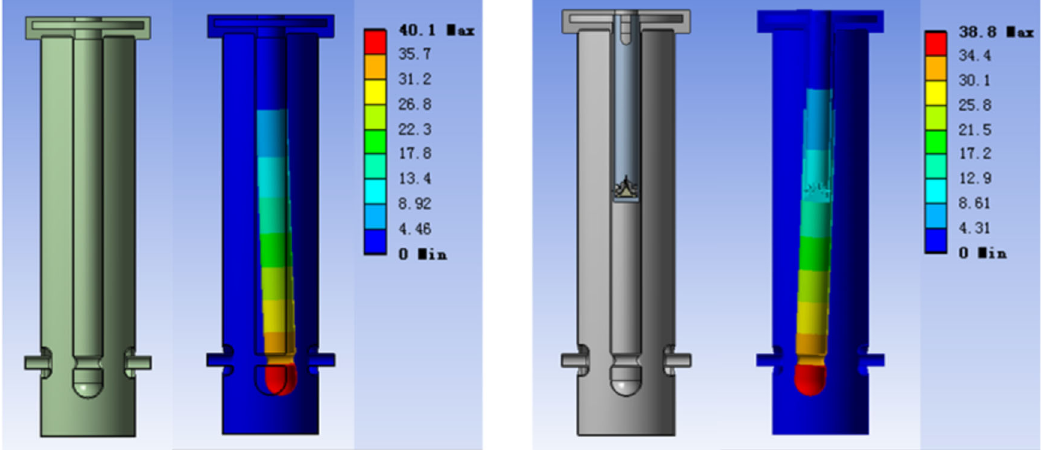
FIG. 5. Displacement pattern of the fundamental mode with scale in microns. Left: No damper; right: damper installed. The left pattern also includes the undeformed frame. Fig. 5. Considering the operational condition at 4.2 K, there will be about a 15% rise on Young ’ s modulus of niobium and a 7% rise for stainless steel [21,22], with a correspond- ing 7.5% improvement on the modal frequency expected.